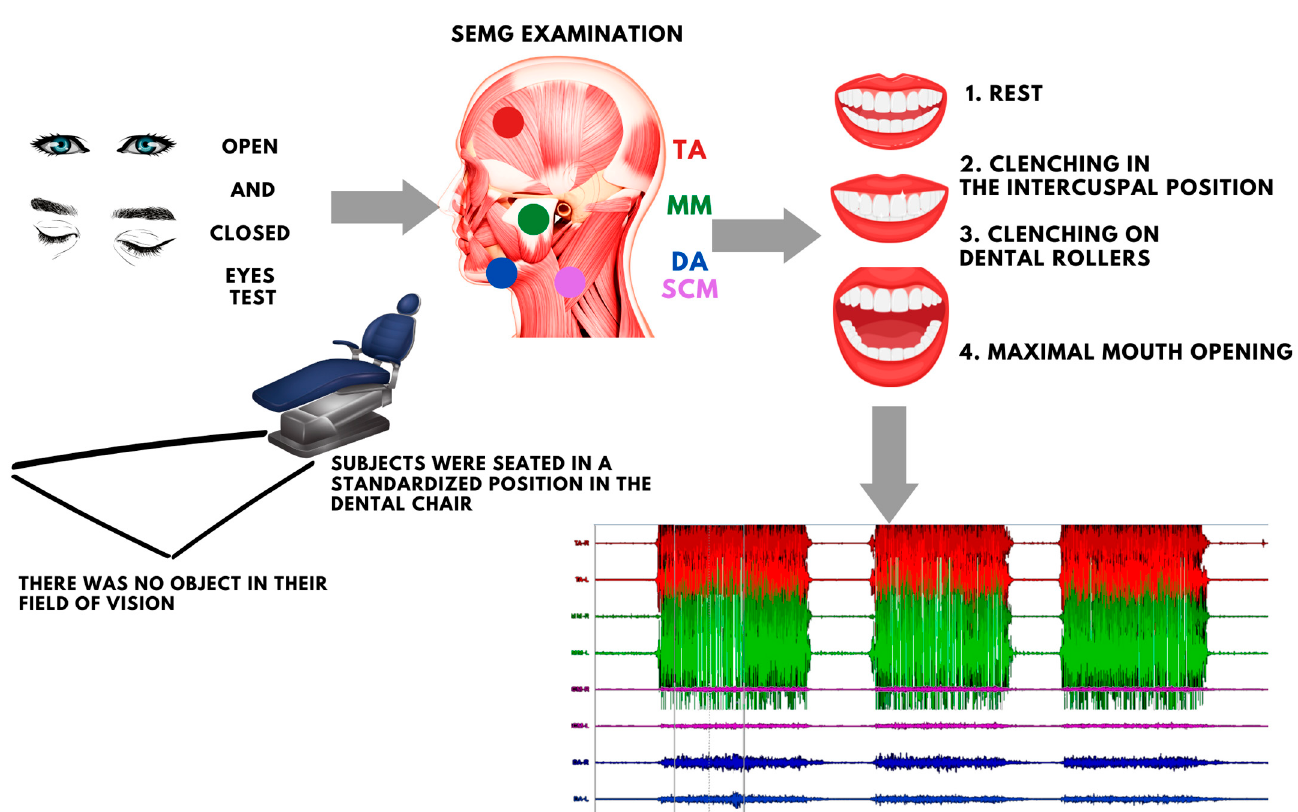
Figure 1. Schematic order of the study. TA—the anterior part of the temporalis muscle; MM—the superficial part of the masseter muscle; SCM—the middle part of the sternocleidomastoid muscle; DA—the anterior belly of the digastric muscle.